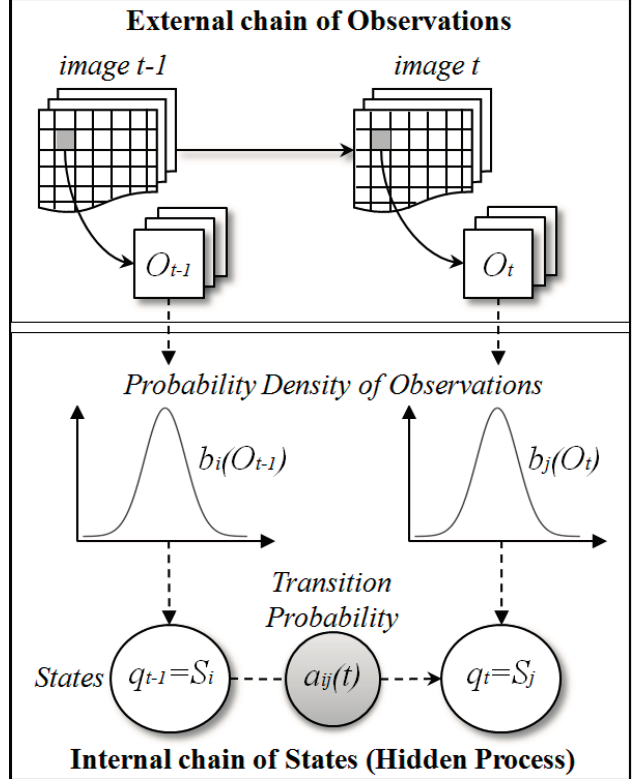
Figure 7. Schematic description of the basic elements of the proposed